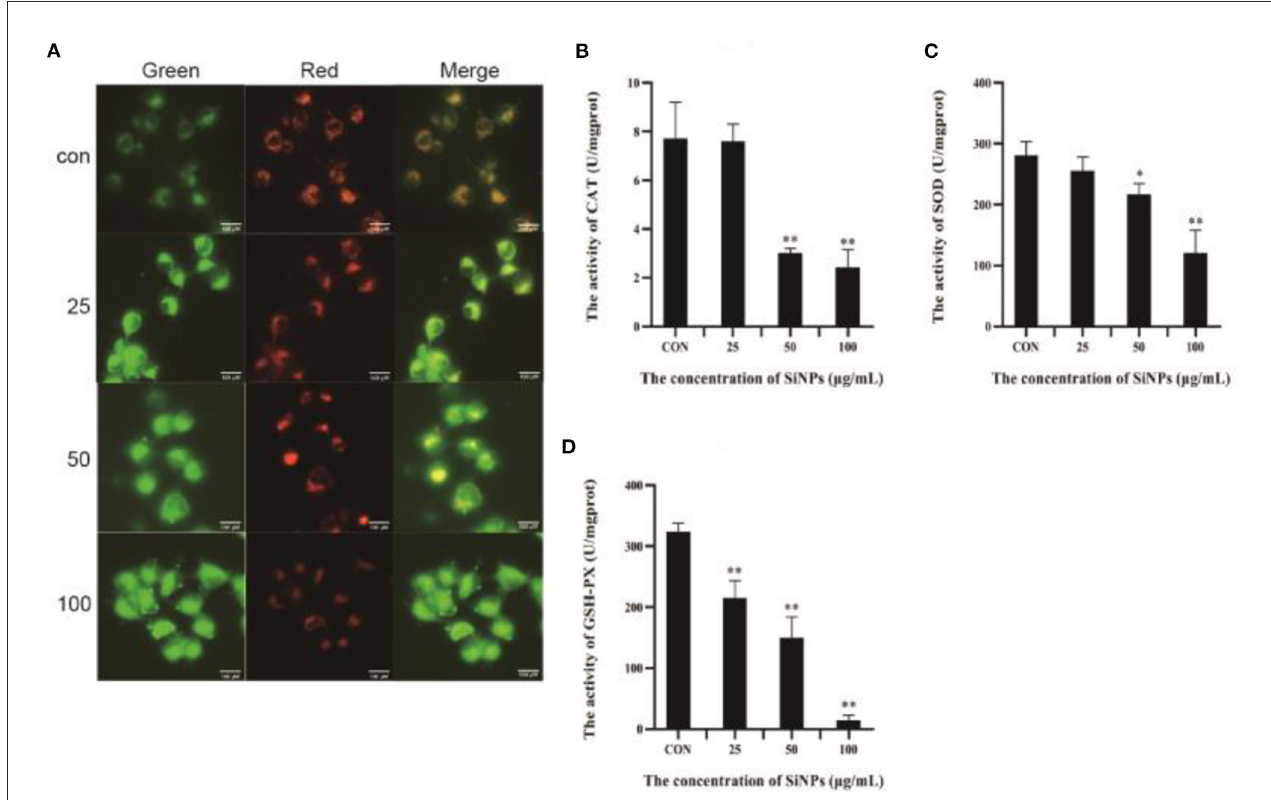
FIGURE4 The impairment of mitochndria and activities of anti-oxidative enzymes. (A) The changes of mitochondrial membrane potential (intensity of the red fluorescence is positive correlation to the height of mitochondrial membrane potential). (B) The activities of CAT. (C) The activities of SOD. (D) The activities of GSH-PX. [* p < 0.05, ** p < 0.01, compared with the con, n =